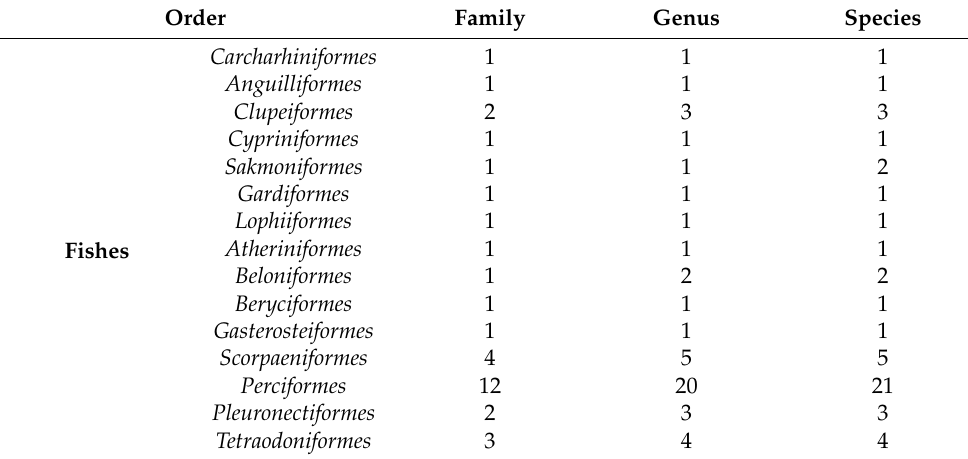
Table 1. Fish and cephalopod species captured in set nets in the coastal waters of Yangyang from February 2007 to December